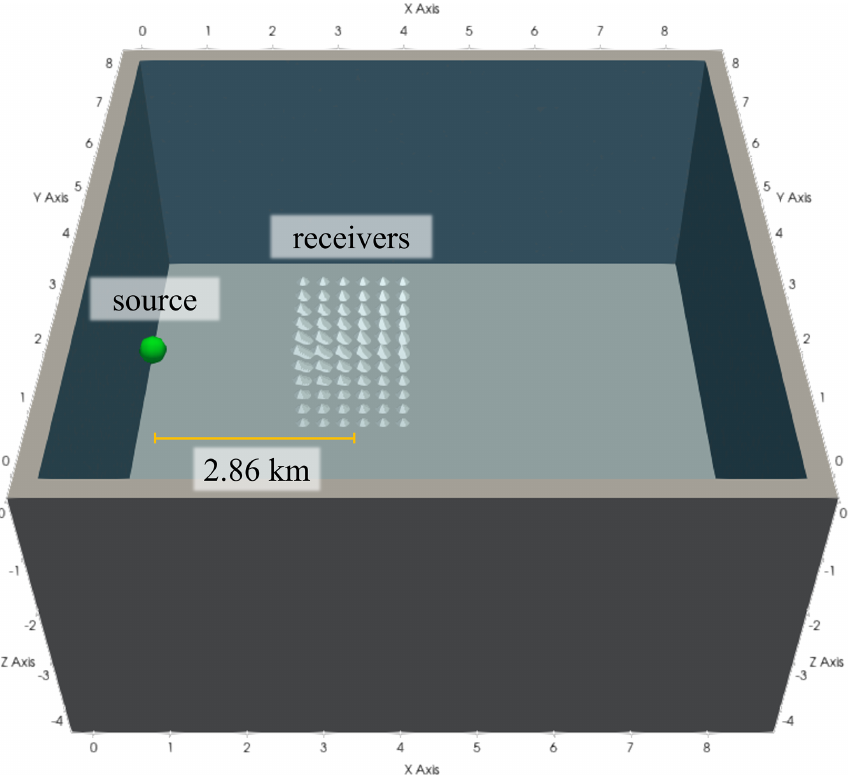
Figure 12. The 3D experimental configuration to calculate the grid-point-per-wavelength G values. The Ricker source is represented as a green sphere, and the receivers are denoted as white pyramid glyphs.